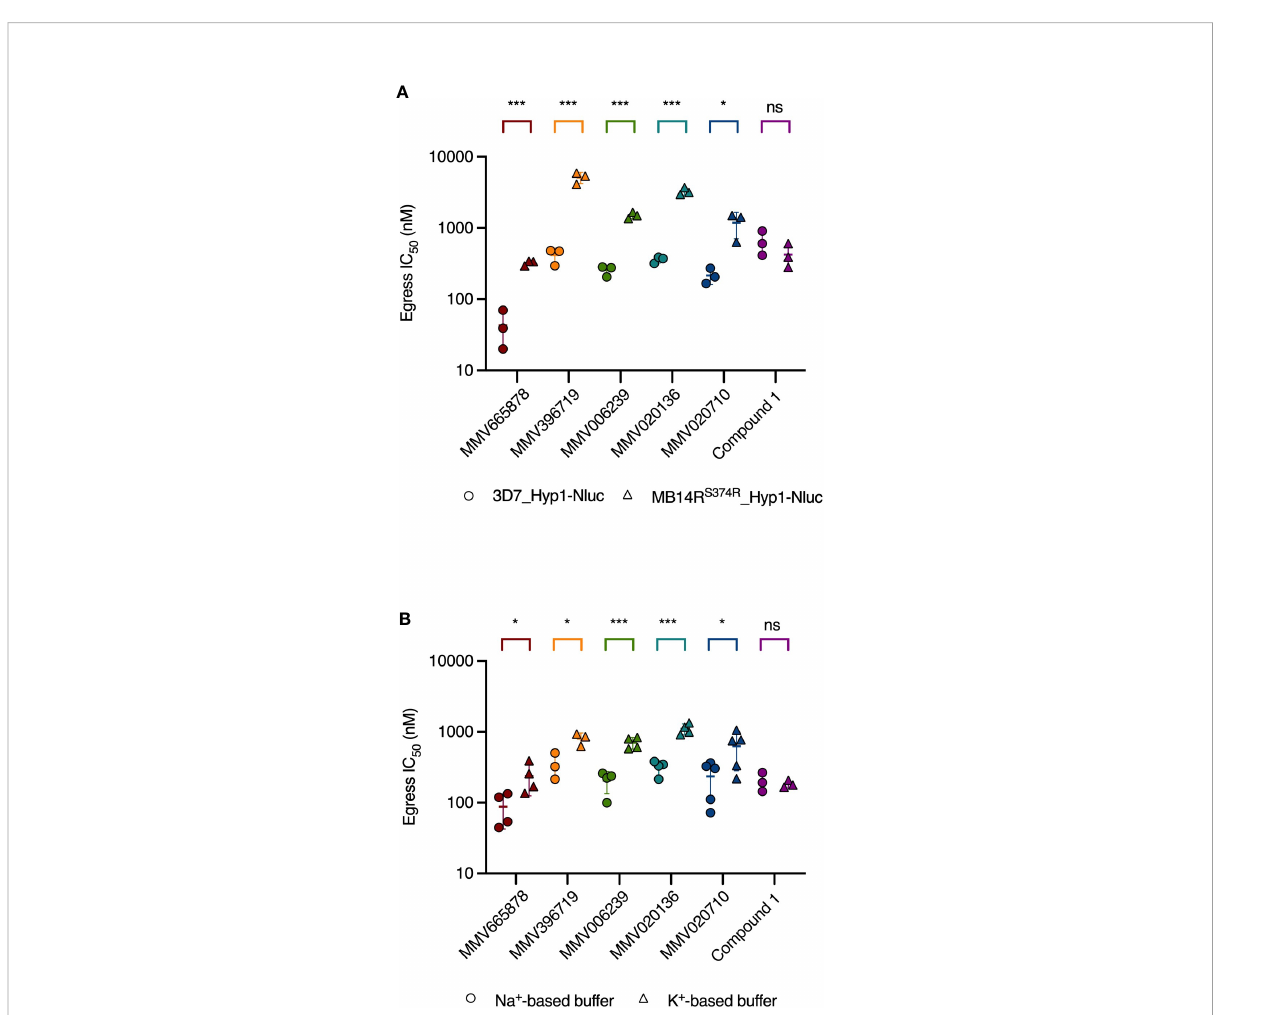
FIGURE 4 The potency of egress inhibition by Pf ATP4 inhibitors is reduced in parasites with a resistance-conferring mutation in Pf ATP4 and in wild-type parasites treated in a Na + -depleted buffer. (A) Pf ATP4-mutant MB14R S374R _Hyp1-Nluc parasites (triangles) are less sensitive than 3D7_Hyp1-Nluc parasites (circles) to egress inhibition by the Pf ATP4 inhibitors. The potency of the mechanistically unrelated egress inhibitor Compound 1 does not differ signi fi cantly between the two parasite lines. (B) 3D7_Hyp1-Nluc parasites are less sensitive to egress inhibition by Pf ATP4 inhibitors when suspended in a Na + -depleted, K + -based buffer (triangles) than when suspended in a buffer with a Na + concentration equal to that of standard RPMI medium (circles). For Compound 1, the IC 50 for egress inhibition (derived from the graphs shown in Supplementary Figure 8) does not differ signi fi cantly between the two buffers. Synchronised late-stage schizonts [40-43 hpi (A) or 40-42 hpi (B) ] were treated with a 2- fold dilution series of each test compound and incubated for 4 h. Egress was then quanti fi ed by measuring the bioluminescent signal intensity of nanoluciferase released into the growth medium. Lines and error bars indicate the mean IC 50 ± SD of at least three biological replicates, each consisting of technical duplicates. The statistical signi fi cance of the difference between mean IC 50 s for was calculated using the unpaired Student ’ s t-test (ns: not signi fi cant, *p<0.05, ***p<0.001). IC 50 values, fold differences and p-values are listed in Supplementary Table